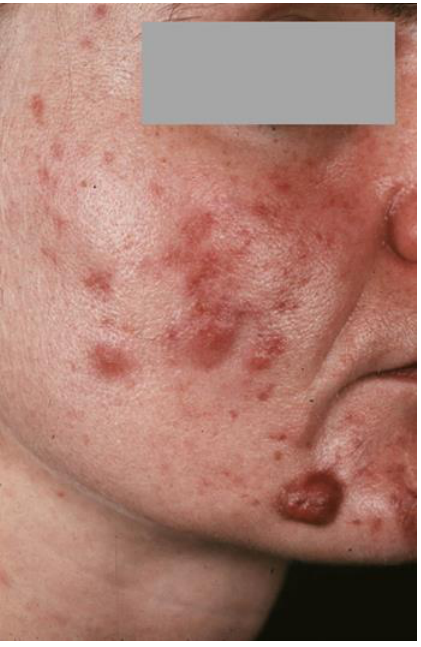
Figure 1. 31-year-old patient suffering from severe late-onset acne tarda.